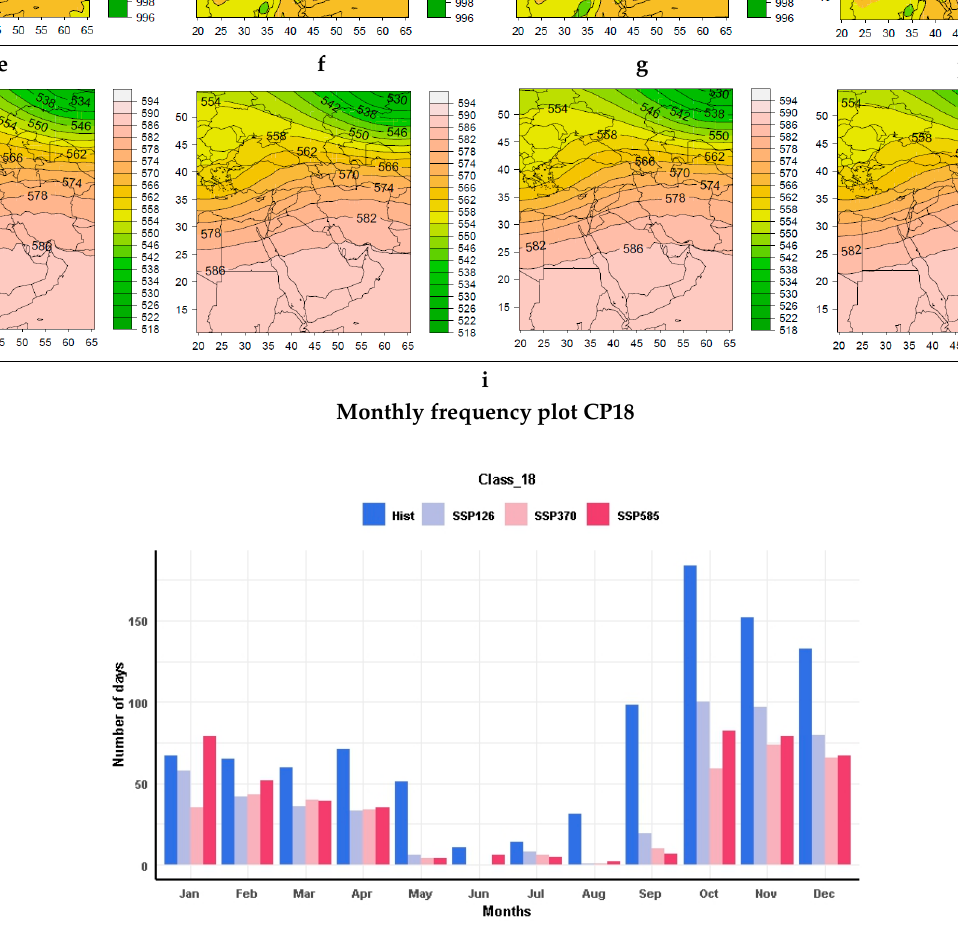
Figure 20. As in Figure 3 for